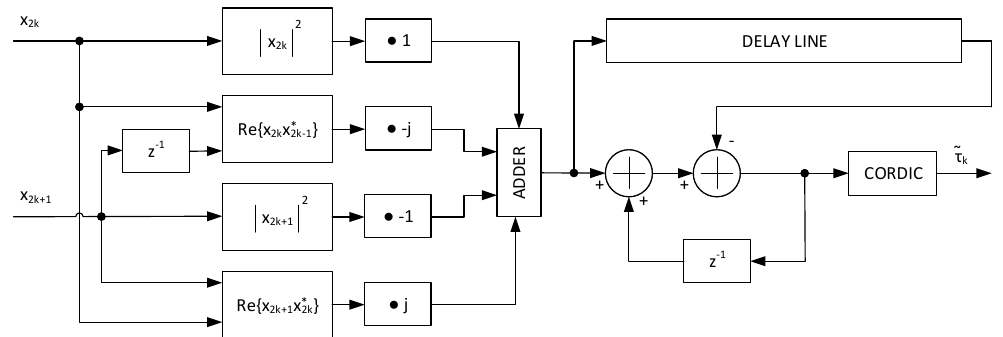
Figure 20. Architecture of the two-parallel Lee timing error detector.